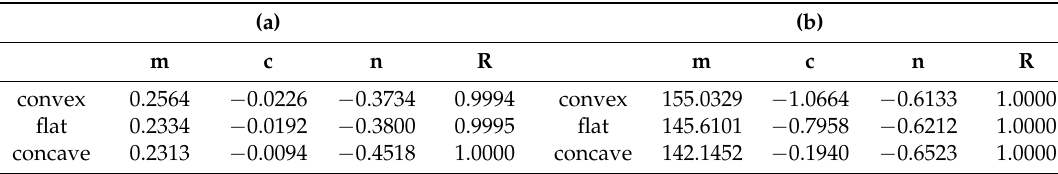
Table 2. Fitting parameters, y = m • x n + c used for the ( a ) dimensionless currents and ( b ) collection percentages differences of Figure 6. R represents the fitting